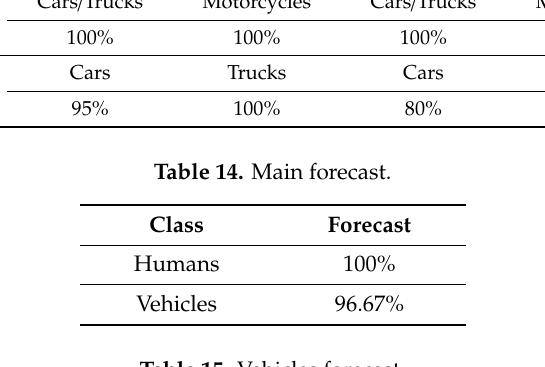
Table 15. Vehicles